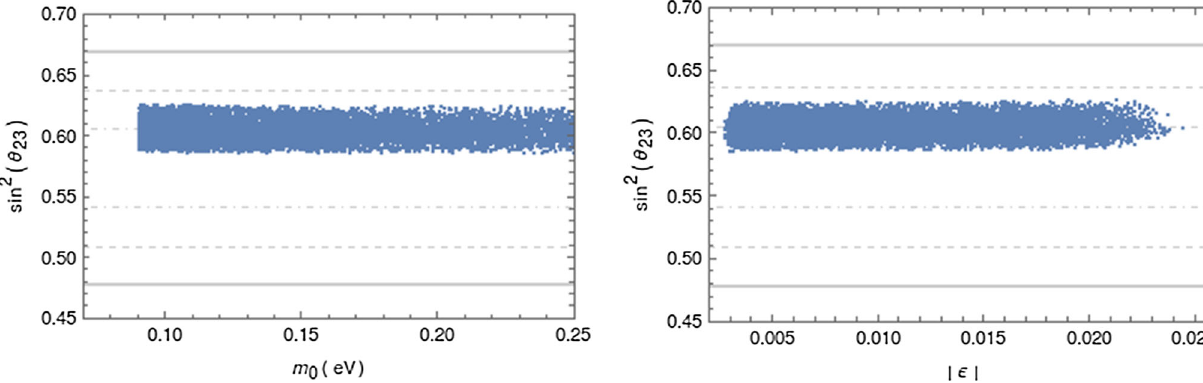
Fig. 4 Case D : Allowed region for sin 2 θ 23 . The dot-dashed , dashed and thick lines stand for 1 σ , 2 σ and 3 σ of C. L